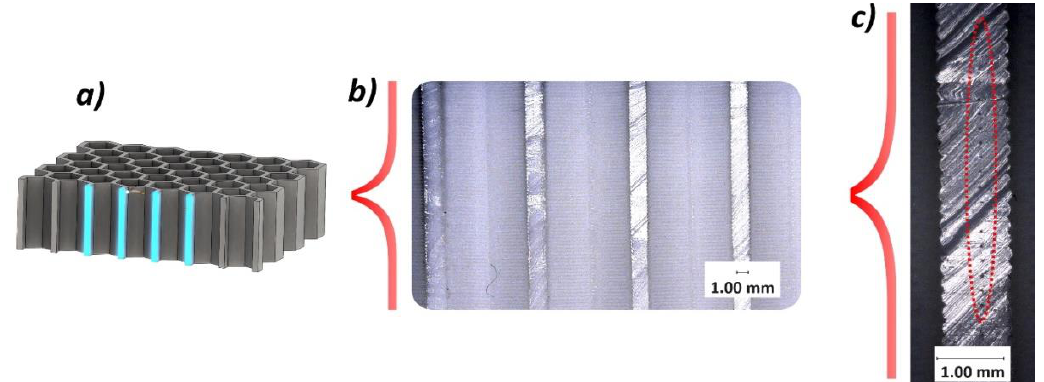
Figure 7. The view of the side surface of 3D printed honeycomb specimen: ( a ) 3D CAD model, ( b ) general view of specimen, ( c ) view with magnitude ×20.